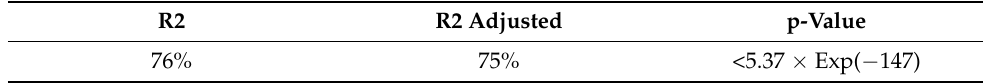
Table 2. General characteristics of the